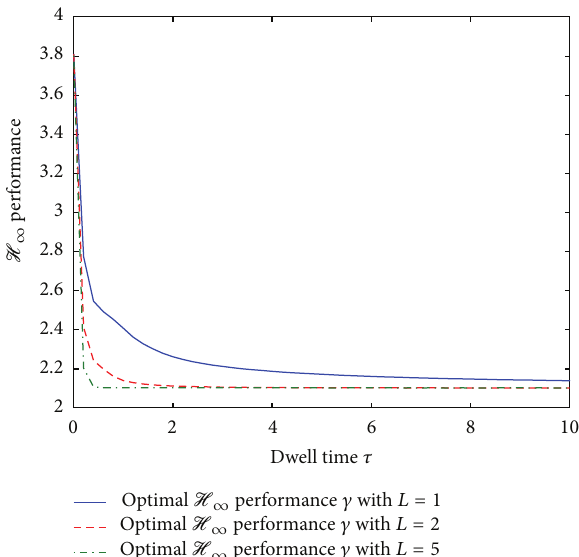
Figure 1: Computation on optimal H ∞ control performance versus dwell time with different 𝐿